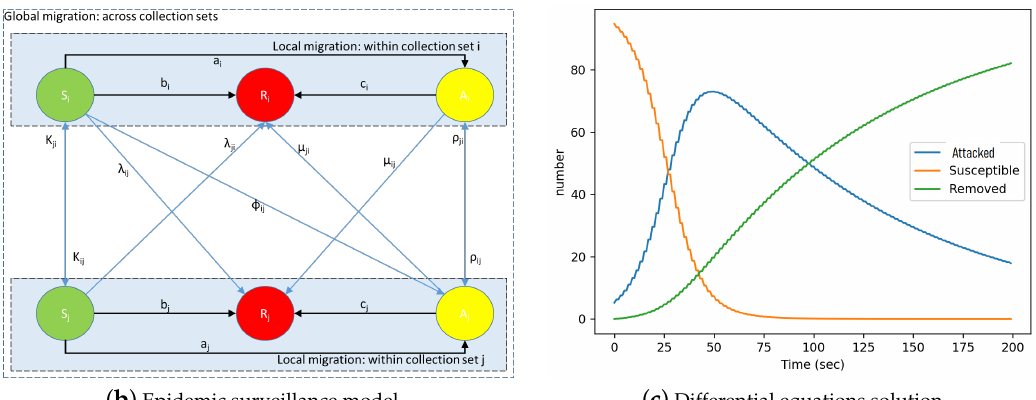
( c ) Differential equations solution. Figure 3. The epidemic